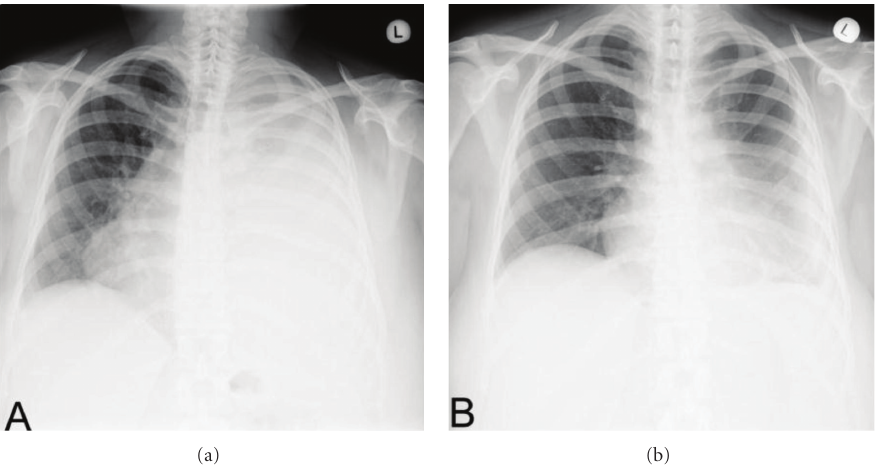
Figure 1: (a) Chest X-ray of patient showing massive left pleural e ff usion and (b) reduction of the pleural e ff usion after two doses of intrapleural